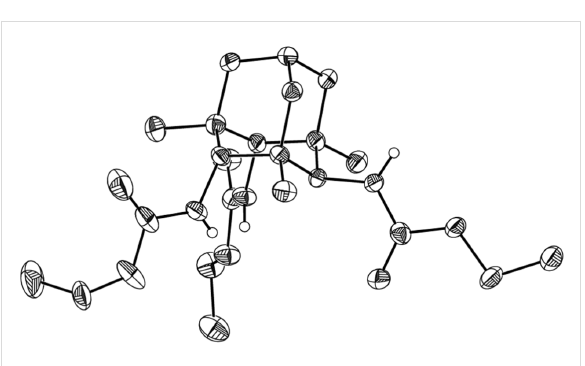
Figure 3: General view of 13b in representation of atoms with thermal ellipsoids at 50% probability level; all hydrogen atoms (except for those of the NH groups) are omitted for clarity. The compound crystallizes as a crystallosolvate with two water molecules and one methanol entity (those are not shown) per two symmetry-independent molecules of the product. CCDC 1501437 contains the supplementary crystallographic data for 13b . These data can be obtained free of charge via http:// www.ccdc.cam.ac.uk/conts/retrieving.html (or from the CCDC, 12 Union Road, Cambridge, CB21EZ, UK; or